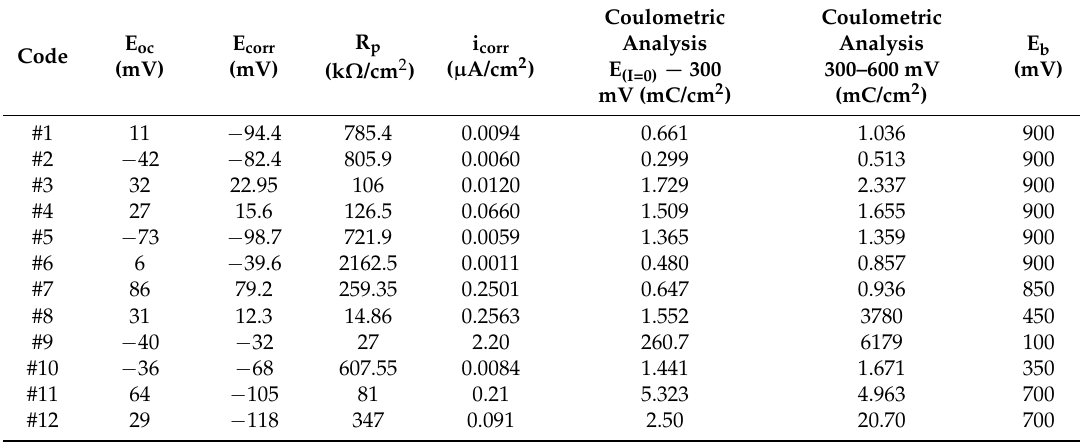
Table 3. Electrochemical parameters measured and calculated for the different grades of